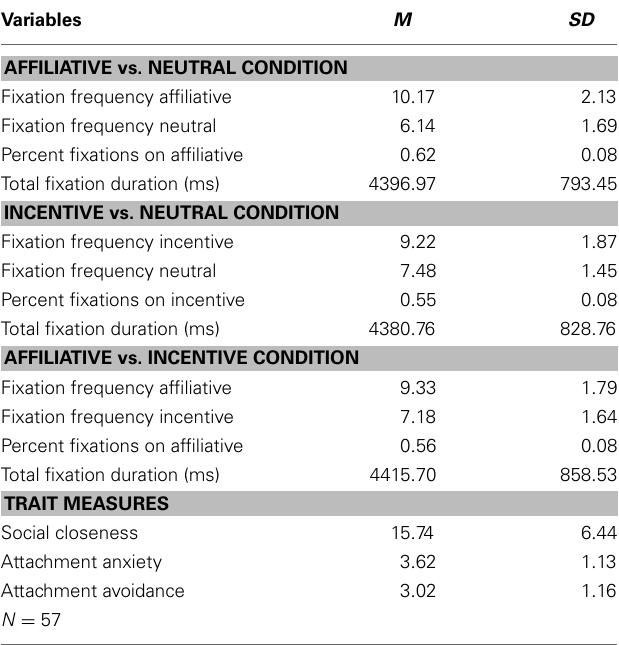
Table 1 | Descriptive statistics for eye movement parameters and trait